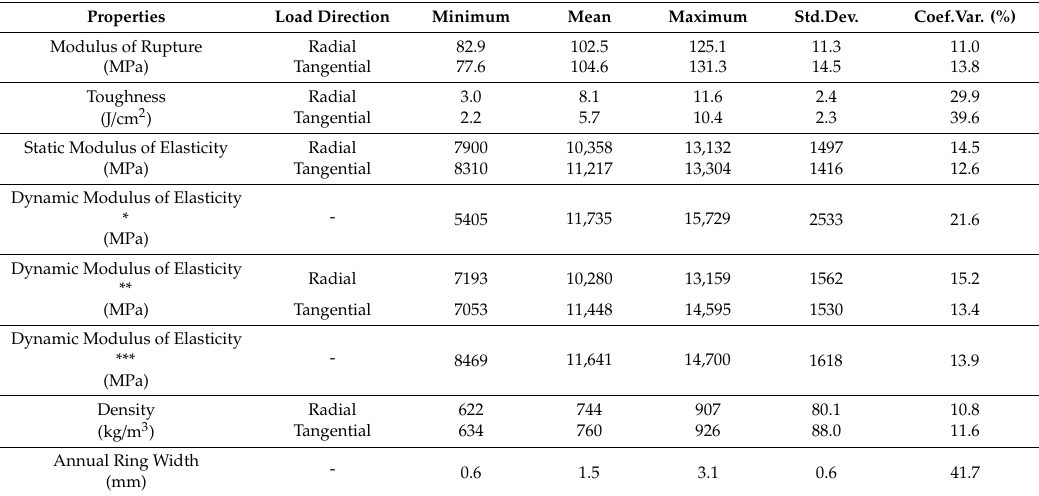
Table 2. Basic Statistical Analyses of the Properties for Larch Wood.